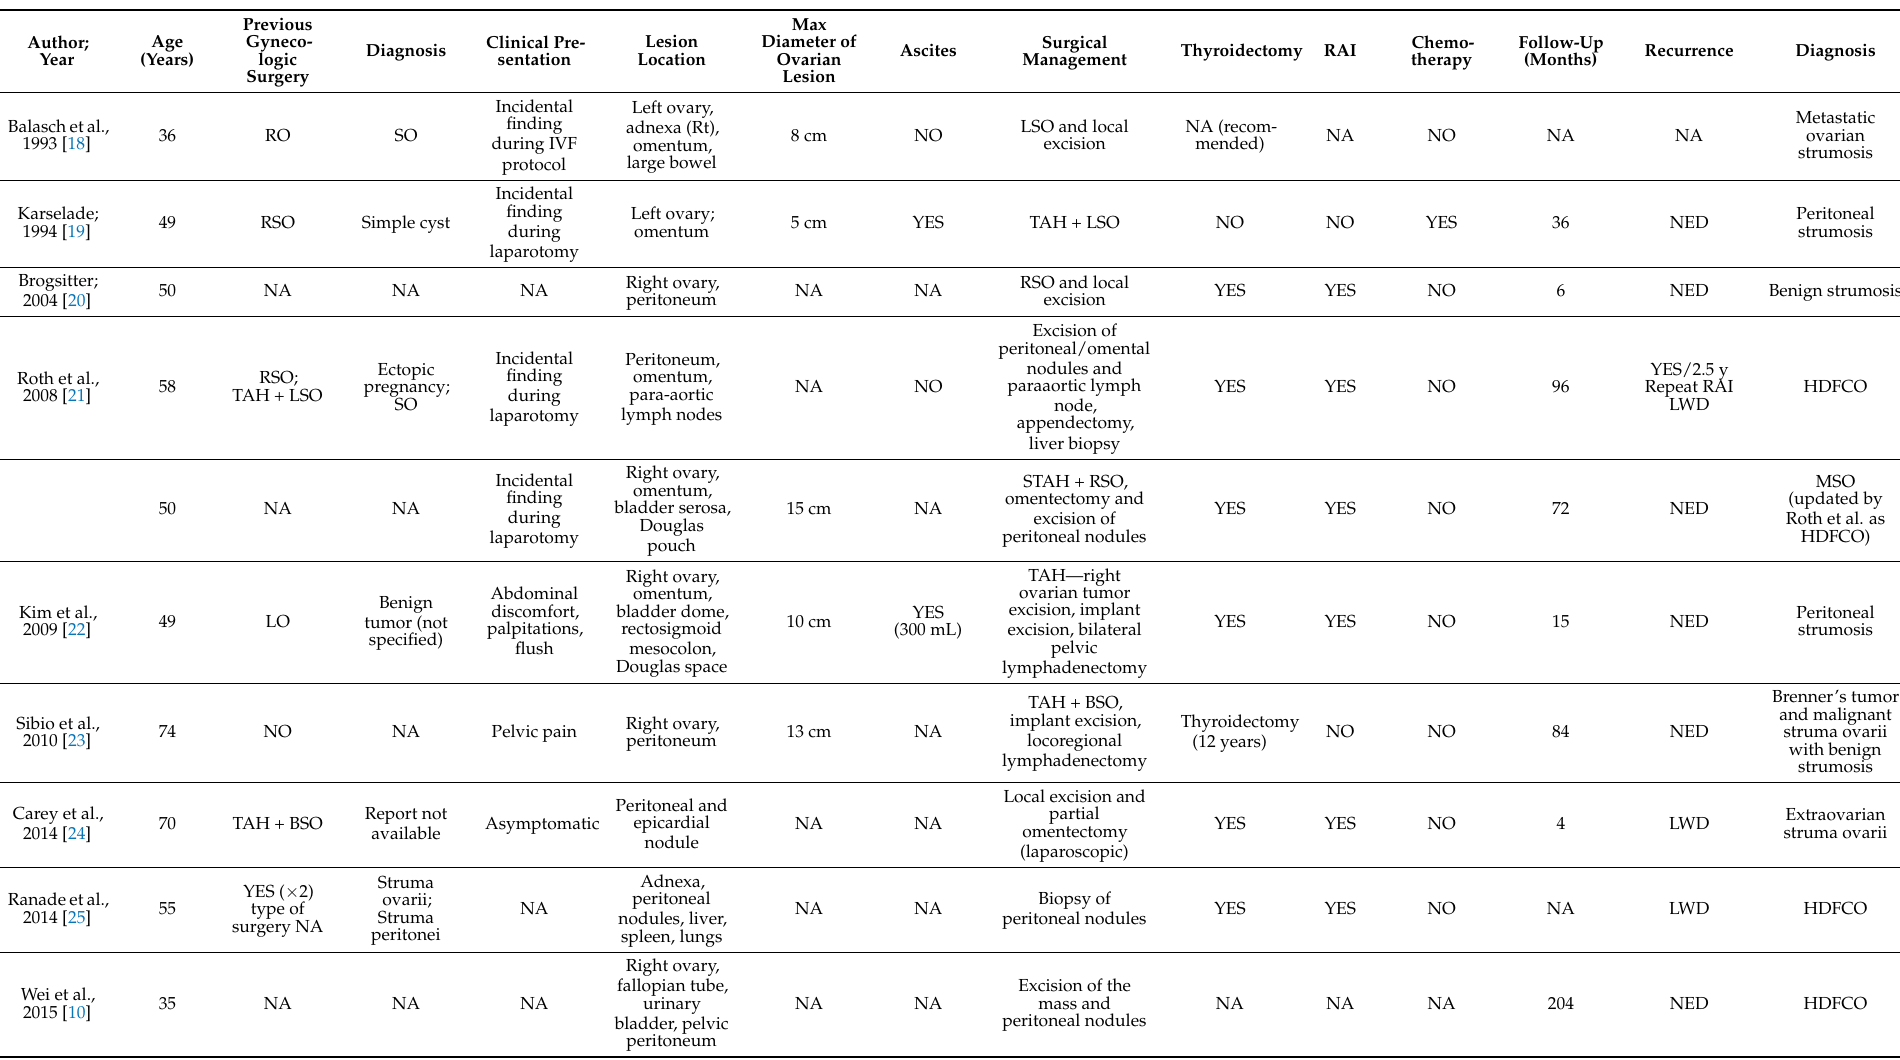
Table 1. Patients’ characteristics and measured